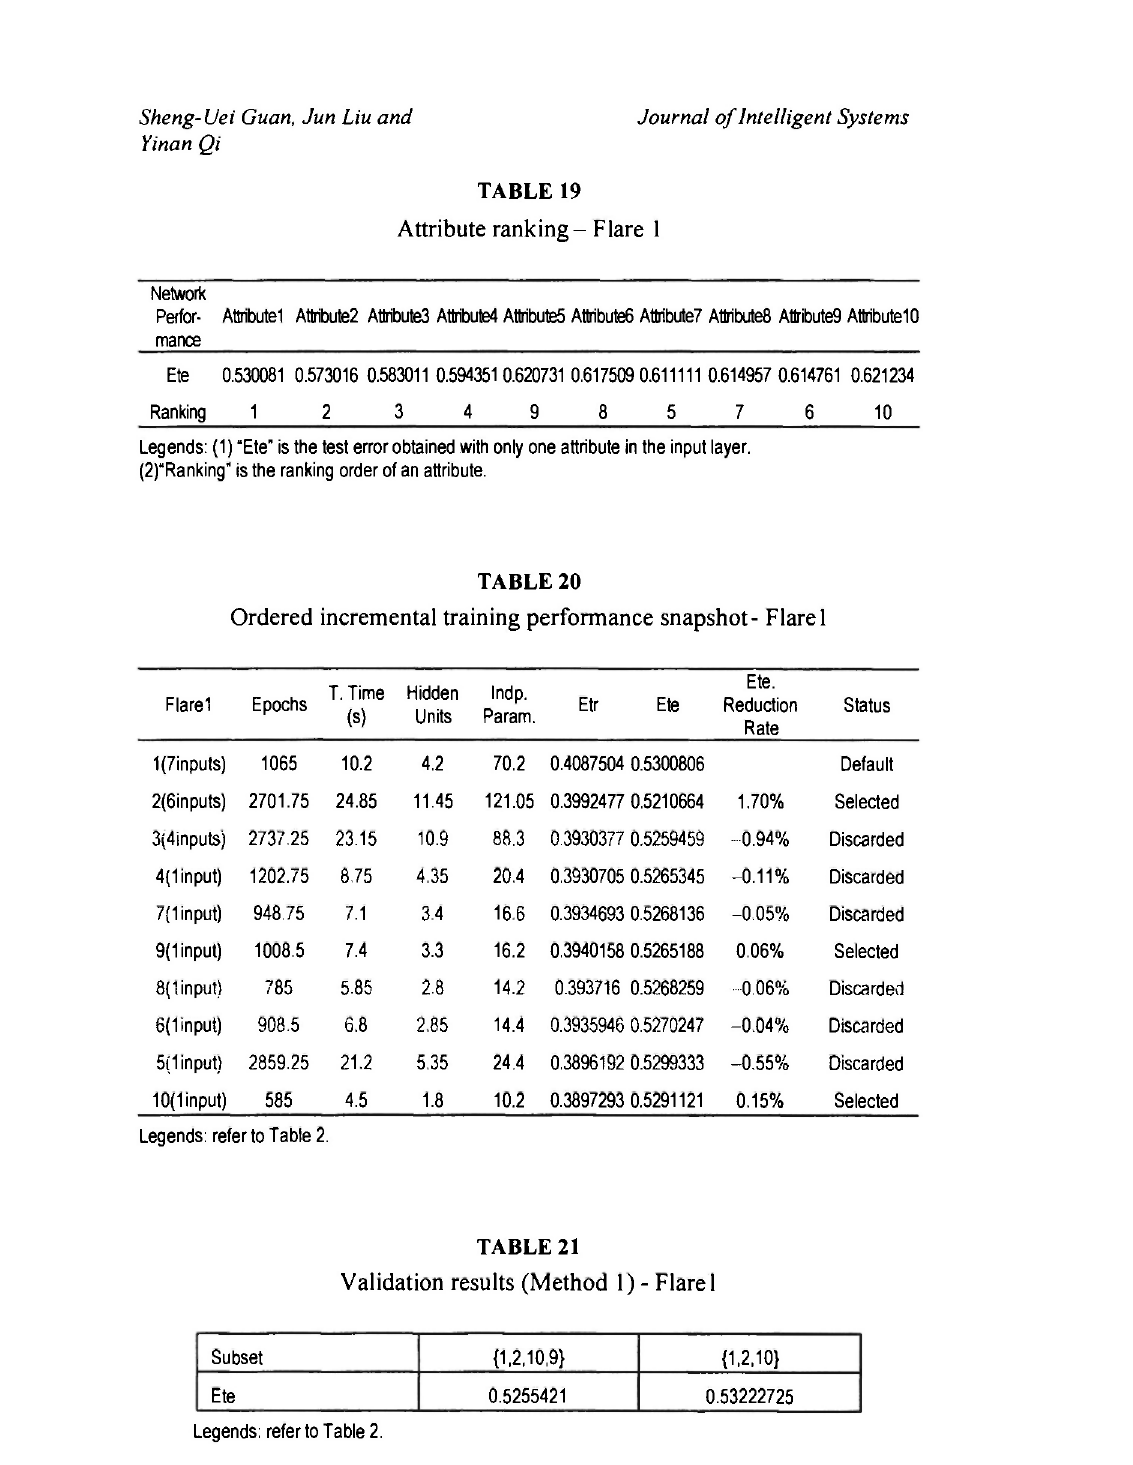
Validation results (Method 1) -